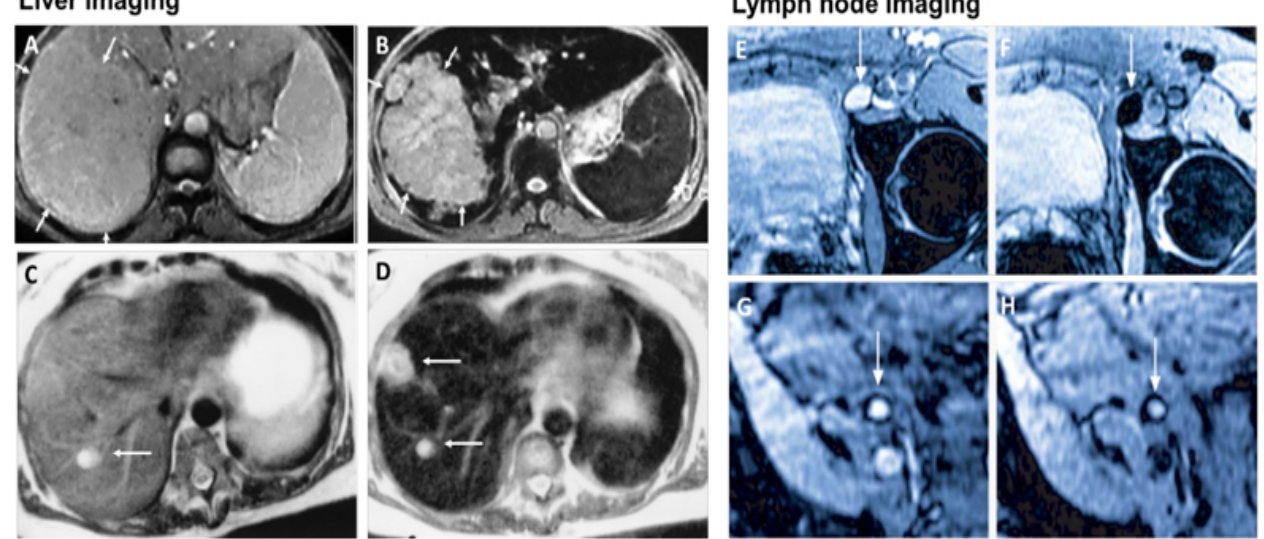
Figure 2. Superparamagnetic iron oxide NPs being used in liver imaging and lymph node imaging. ( A , B ): T2-weighted MR image of a liver with a large hepatocellular carcinoma before ( A ) and after ( B ) the administration of SPION. The lesion is demarcated with arrows. ( C , D ): Standard ( C ) and SPION-based contrast-enhanced ( D ) MR imaging of liver metastasis in a patient with colorectal cancer. After administration of ferumoxide SPION, a second metastasis becomes visible on T2-weighted MR image. ( E , H ): Lymph node in left iliac region (arrow), with and without metastatic infiltration. T2-weighted images before ( E , G ) and 24 h after ( F , H ) administration of ferumoxtran. Lymph node (arrow) appears bright before injection of UPIO ( E , G ). One day after injection, a signal loss in the lymph node (arrow) due to high UPIO macrophage uptake can be observed, thus indicating functionality and no metastasis ( F ). Conversely, in the lower panel, the lymph node (arrow) stays bright, indicating no trafficking of USPIO and thus metastatic colonization ( H ). Reprinted with permission from Ref. [30]. Copyright 2020